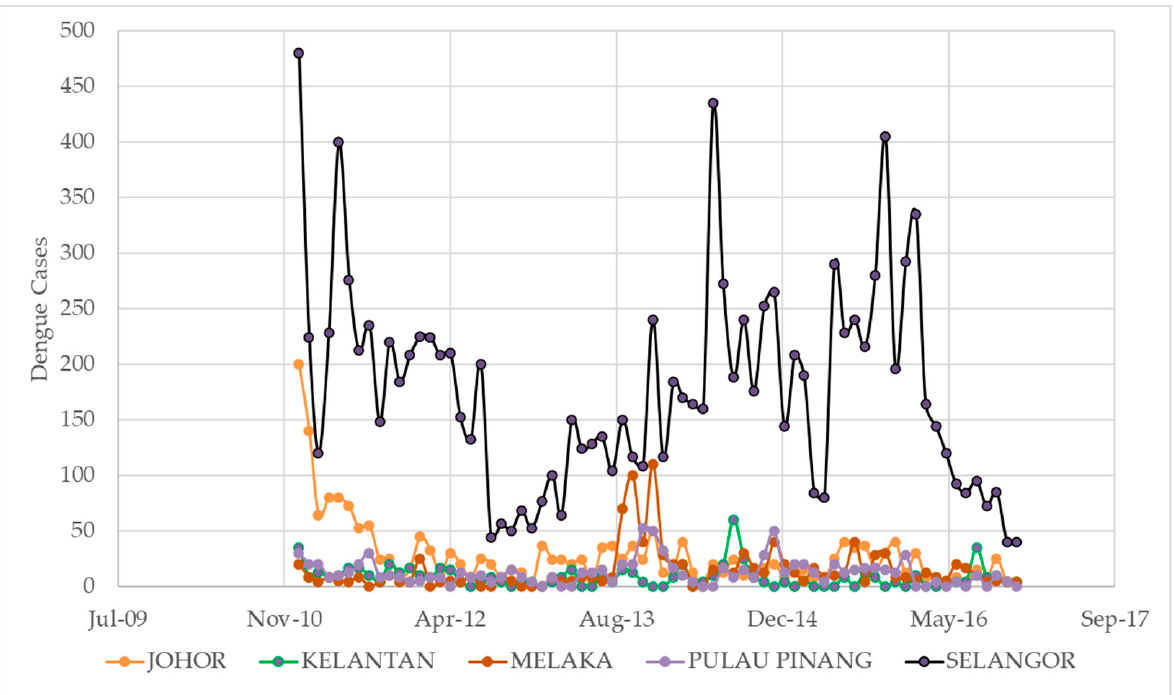
Figure 2. Monthly dengue fever incident cases for five different states in Malaysia from 2011 to 2016.